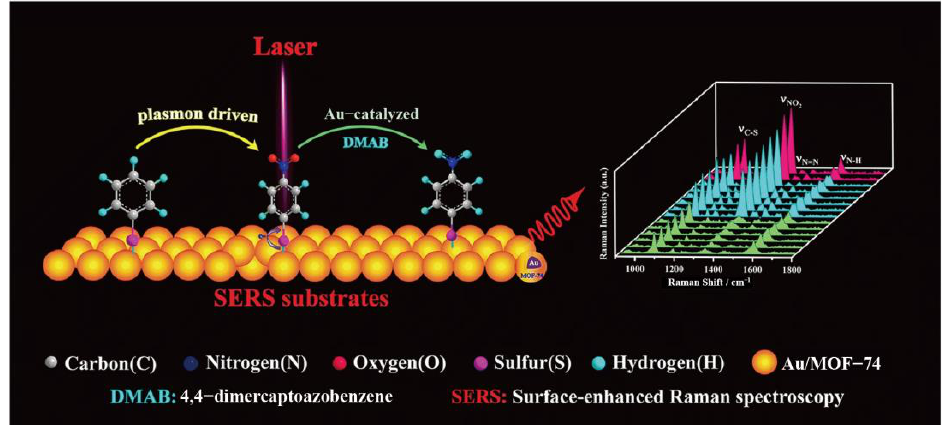
Figure 8. Schematic presentation of a nanoparticle SERS substrate consisting of gold core and MOF-74 shell, which was applied to detection of 4-nitrothiophenol. The Au/MOF-74 was successfully used for in situ monitoring of two model reactions involving 4-nitrothiophenol by SERS. Reprinted with permission from [69]. Copyright Springer-Verlag GmbH Austria, part of Springer Nature 2019.